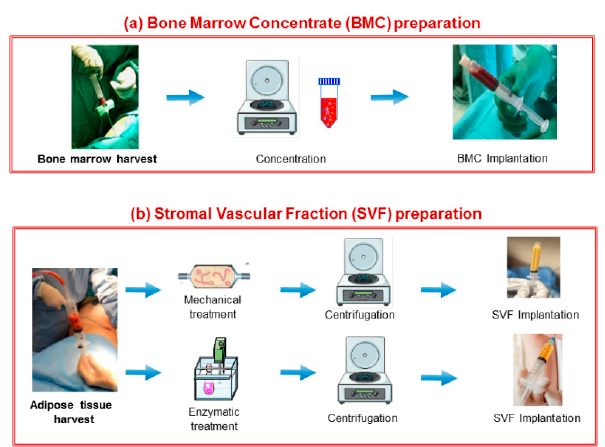
Figure 3. Schematic representation of the procedures needed to obtain ( a ) bone marrow aspirate (BMC) through a cell concentration step, from bone marrow; ( b ) stromal vascular fraction (SVF) from adipose tissue (enzymatic and mechanical procedures, followed by centrifugation).